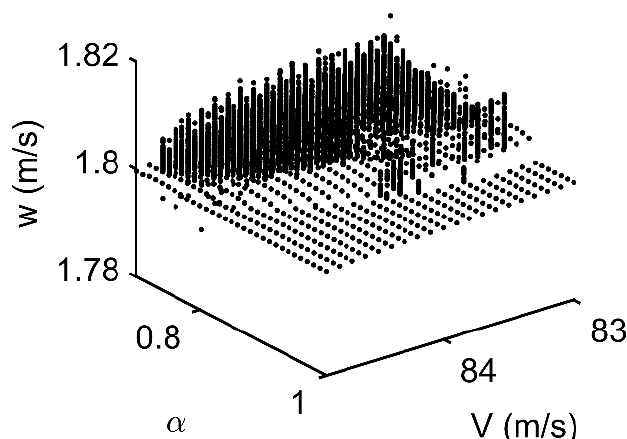
Figure 10. 3D bifurcation diagram of the FOM respecting to both α and V.